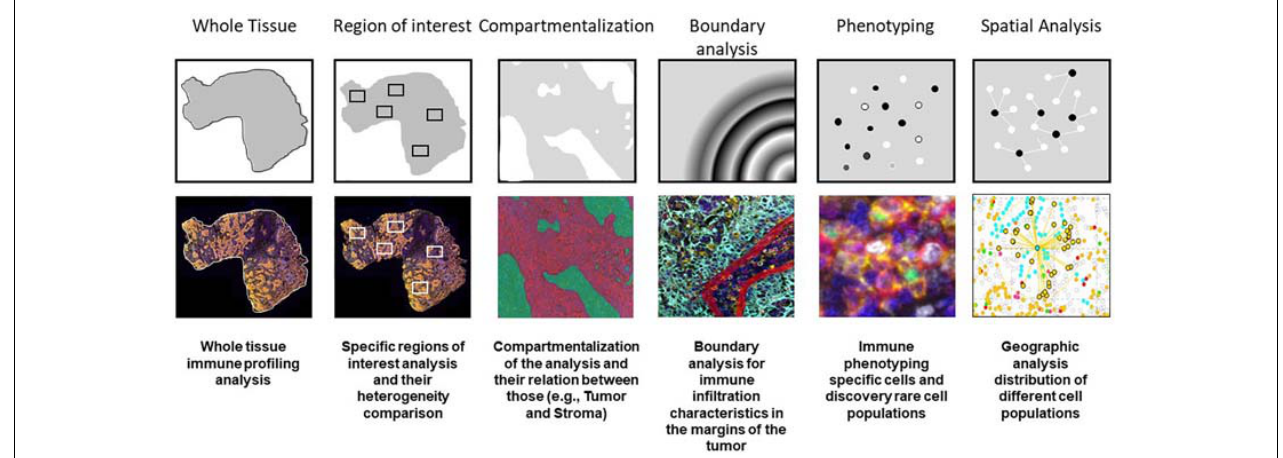
FIGURE 7 | Examples of multiplex immunofluorescence capabilities for tissue immune cell phenotyping spatial